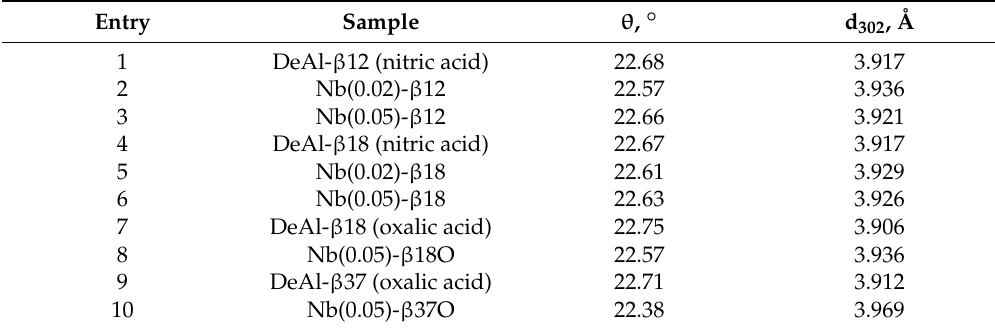
Table 2. The changes in diffraction line from 2 θ 22.48 ◦ and the corresponding d 302 spacing for the Nb-treated